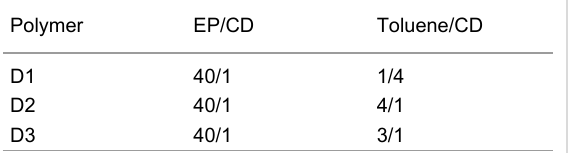
Table 1: Experimental conditions for the synthesis of polymer. a